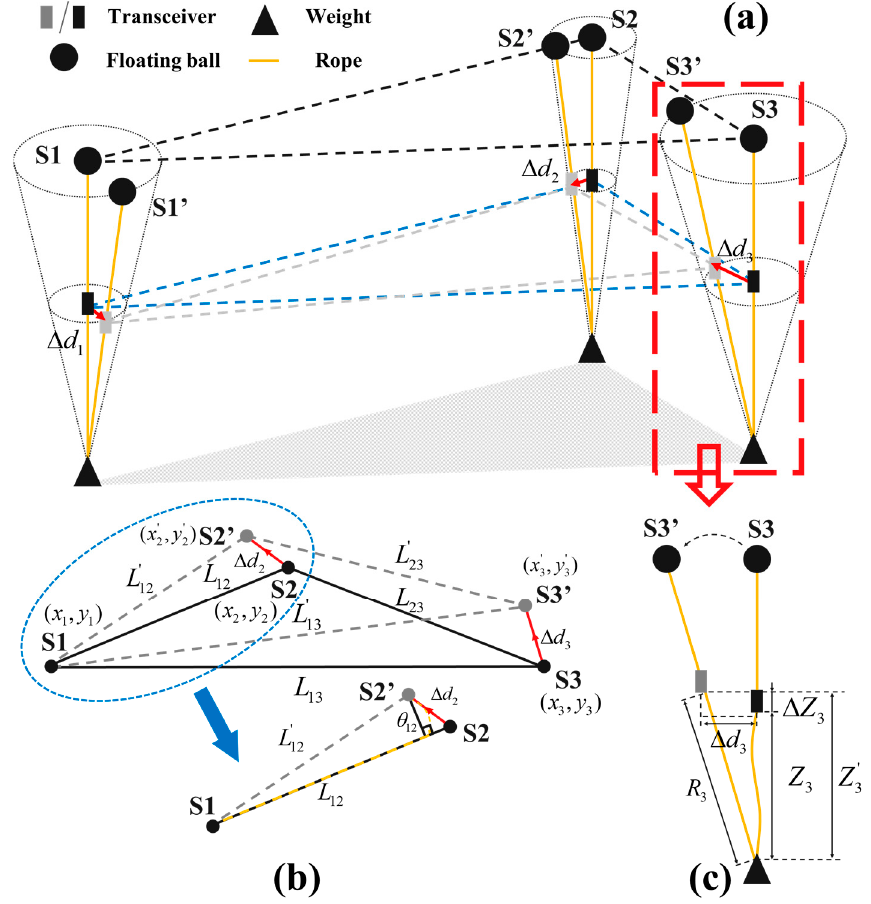
Figure 1. Three-station position correction model: ( a ) shows the transceiver drift processing; ( b ) shows the projection of station drift in horizontal direction; and ( c ) shows station depth variation in the vertical section.